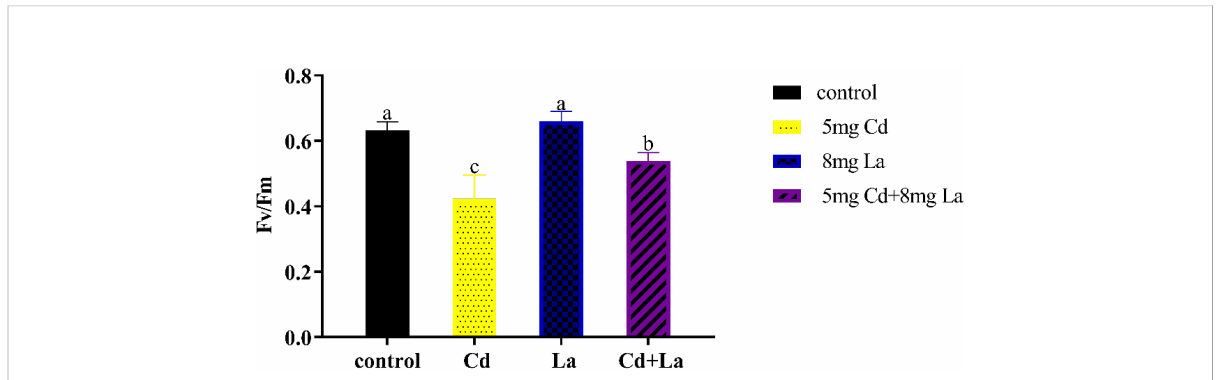
FIGURE 2 Photosynthetic ef fi ciency (Fv/Fm, the maximum quantum yield of photosystem II) of G. bailiniae exposed to Cd, La, and their combination. Units: mg L − 1 . The data are presented as the mean ± standard deviation (n = 3). The lowercase letters indicate signi fi cant differences (ANOVA/ Duncan ANOVA, P<